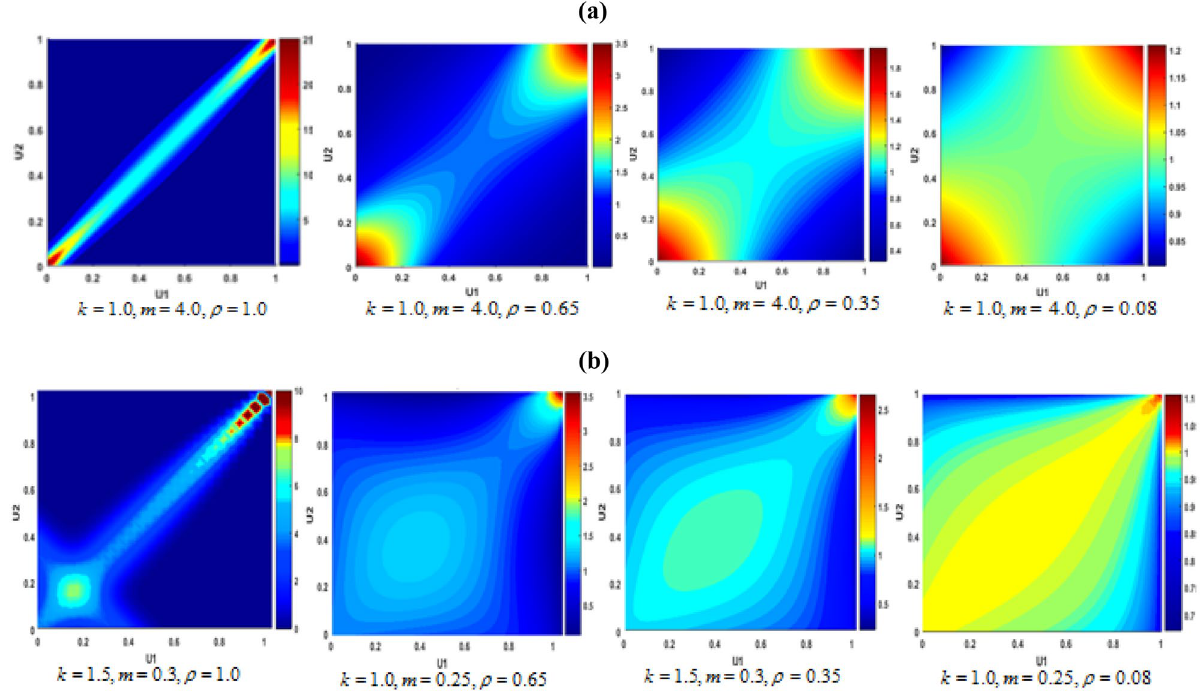
Figure 8. ( a ) Bivariate Gaussian copula densities with different ρ , ( b ) Bivariate v-transformed copula densities with different ρ , m and k . Granite Quartz Basic